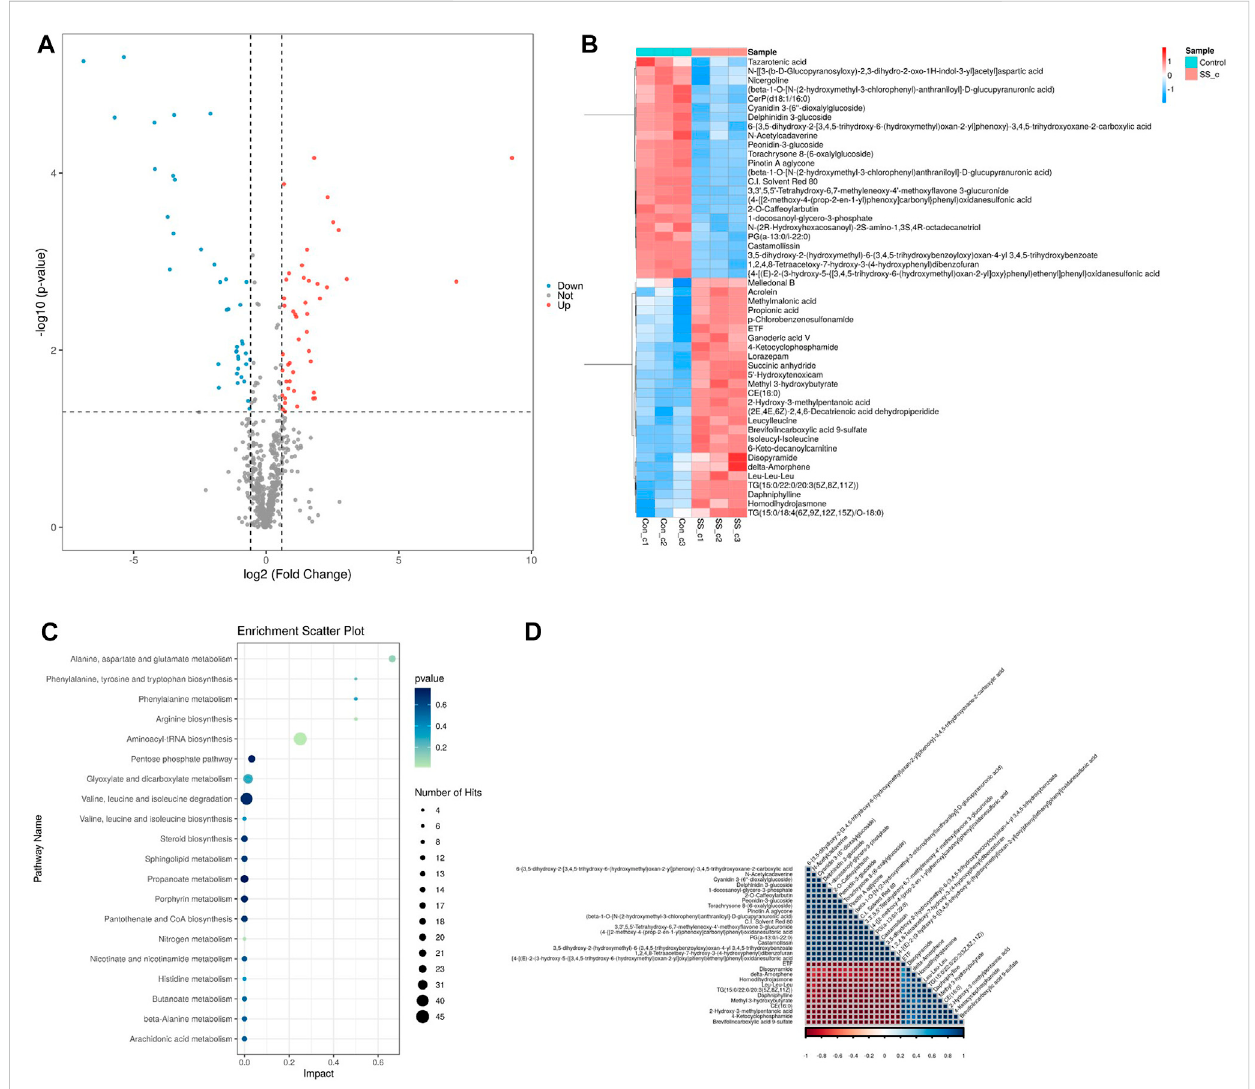
FIGURE 8 Metabolomics analysis on nematodes treated withSSE for 7 days. (A) 49 metabolites were upregulated and 36 metabolites were downregulated followingtheSSEtreatment( p -value < 0.05andFoldChange ≥ 2). (B) Hierarchicalclusteringheatmapofdifferentialmetabolites (C) TheKEGGanalysisof differentially expressed metabolites in SSE-treated Caenorhabditis elegans . (D) Pearson Correlation coef fi cient is used to quantify the linear correlation between all differential metabolites. The closer the square colour of the two metabolites is to red, the stronger the positive correlation between the two metabolites is; conversely, the closer the square colour is to blue, the stronger the negative corelation between the two metabolites